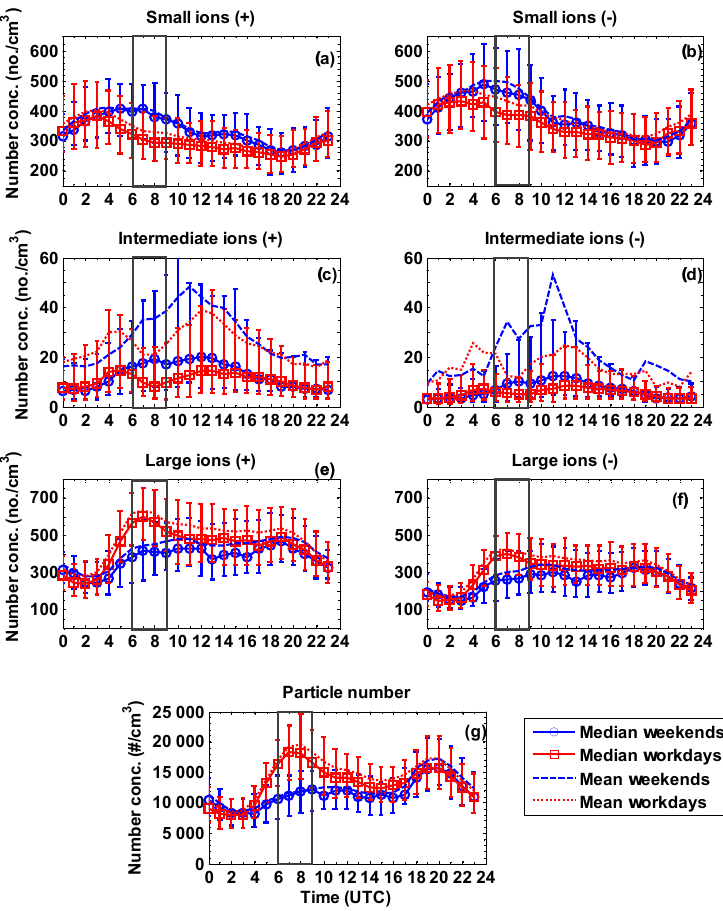
Figure 2. Diurnal cycle of particle number concentrations ( > 6nm) (g) , and small (0.8–2nm), intermediate (2–7nm), and large ions (7– 20nm) (a–f) for workdays and weekends. The markers show the hourly median concentrations and the whiskers show 25th and 75th per- centiles. The dashed lines represent mean concentrations, and the rectangles (06:00–09:00) indicate the morning peak of particle